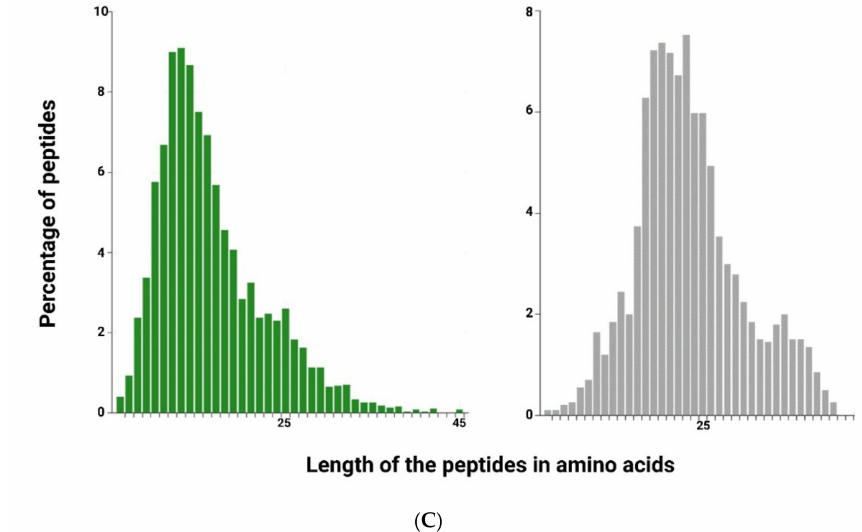
Figure 2. ( A ) Distribution of relative molecular mass for all identified proteins in Arthrospira platensis (green) and in Moringa oleifera (grey) extracts; ( B ) Distribution of protein sequence coverage for all identified proteins; ( C ) Distribution of lengths for all identified peptides.